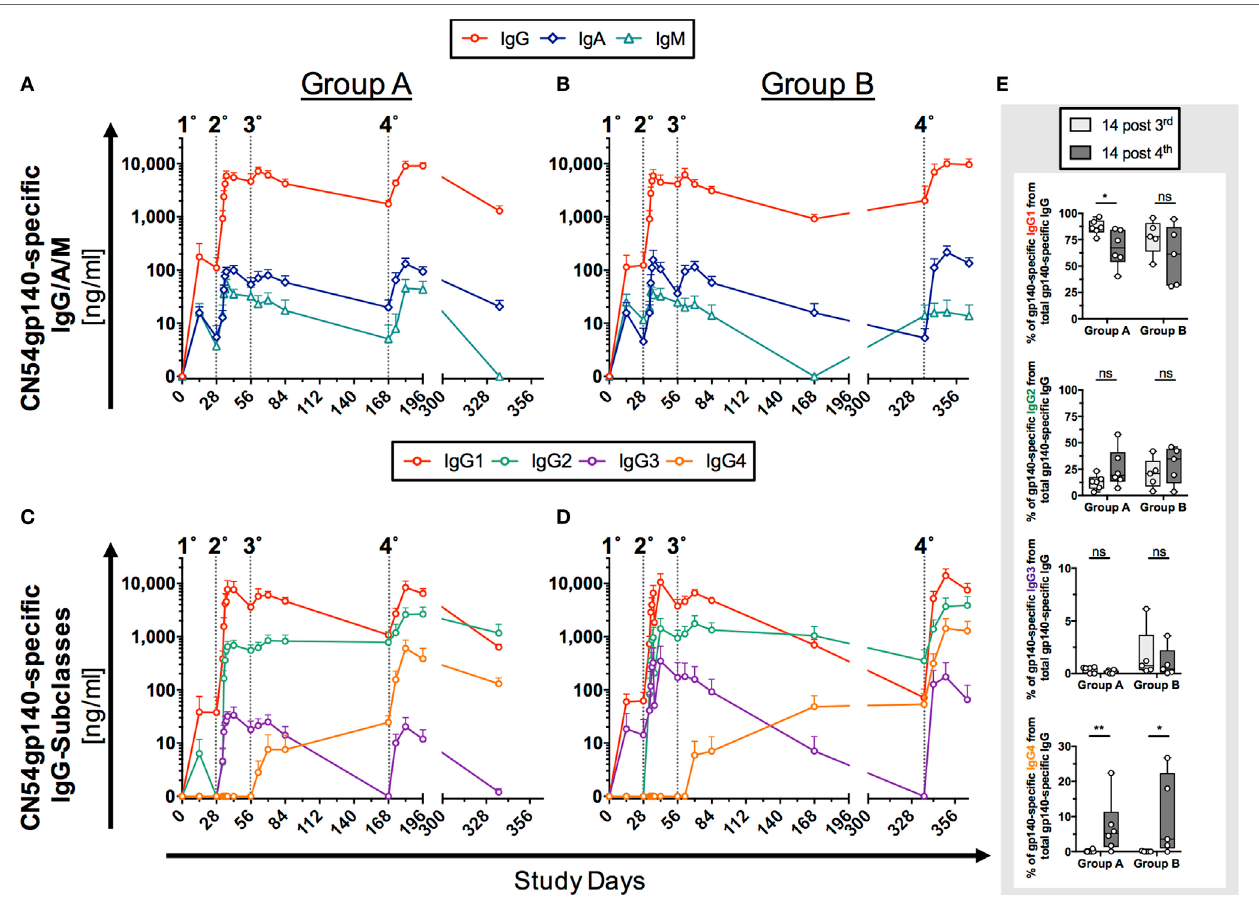
FiGUre 2 | antigen (ag)-specific humoral responses in human serum samples following homologous prime-boost vaccination regimens . Participants received 3 × priming immunizations (IMs) of CN54gp140 adjuvanted with GLA-AF on days 0, 28, and 56, followed by a booster injection at day 168 (Group A) or day 336 (Group B). Indicated by dotted line and numbers 1°–4°. (a,B) CN54gp140-specific IgG, IgA, IgM and (C,D) IgG-subclass concentrations were measured in human serum/plasma and expressed as mean ± SEM. (e) The sum of the four IgG subclasses was calculated and used to determine the percentage of CN54gp140-specific IgG-subclass antibodies 14 days after the priming phase (D70) and 14 days after the respective booster injections (D182/D350) for both Groups A and B. The proportion of Ag-specific IgG1 was decreased, while Ag-specific IgG4 levels were significantly increased after the respective booster IMs. Non-parametric Mann–Whitney test (* p < 0.05, ** p <